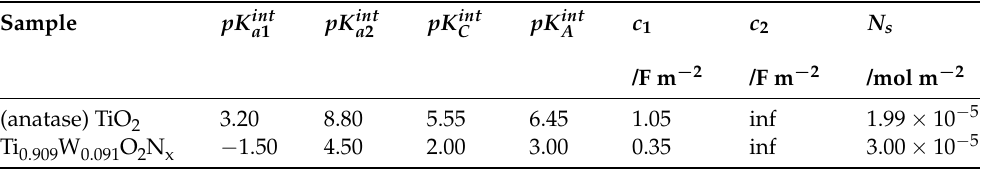
Table 3. 2-pK TLM modelled parameters for TiO 2 and Ti 0.909 W 0.091 O 2 N x colloidal nanoparticles aqueous solutions with I = 10 − 2 molL − 1 adjusted with NaNO 3